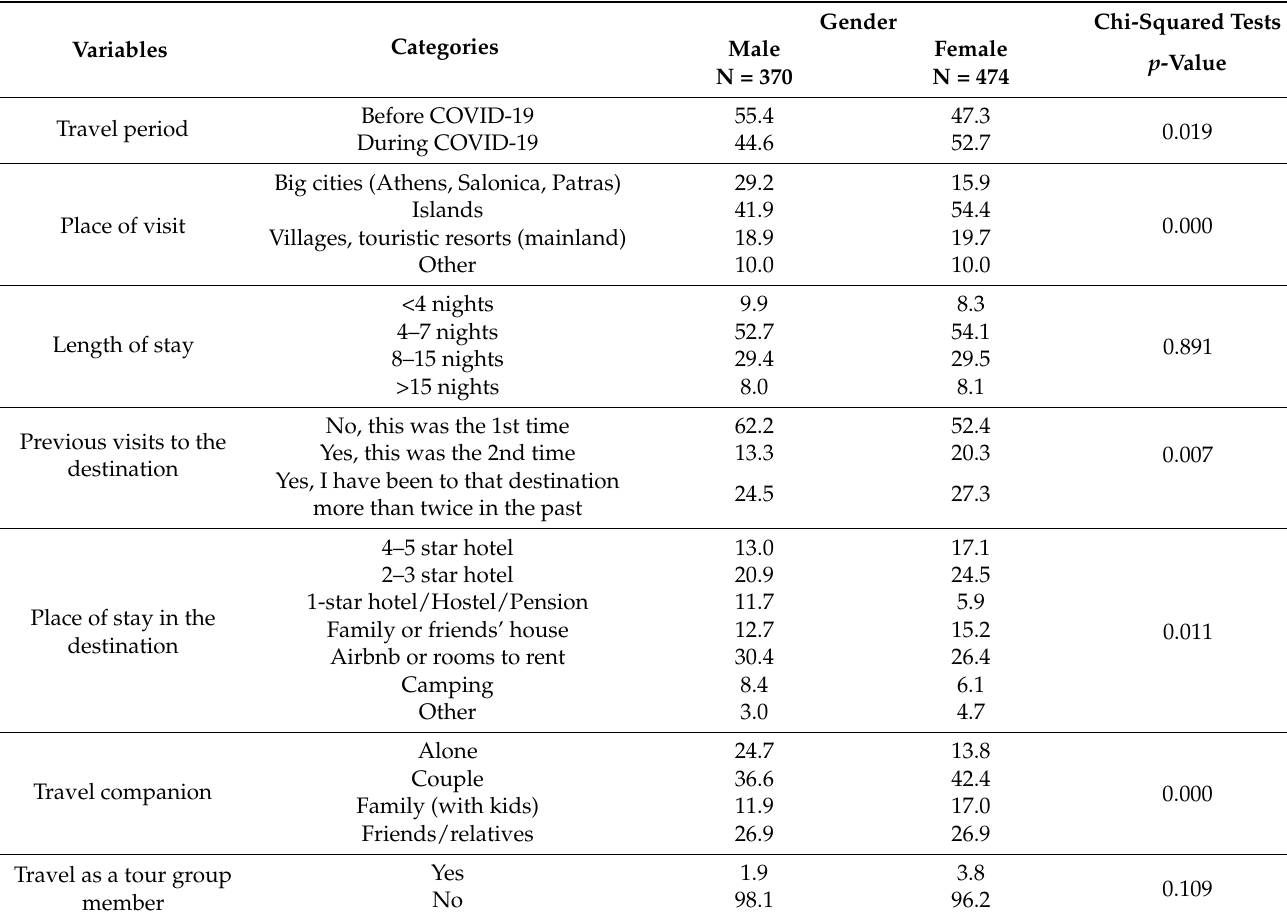
Table 2. The distribution of travel characteristics according to gender.